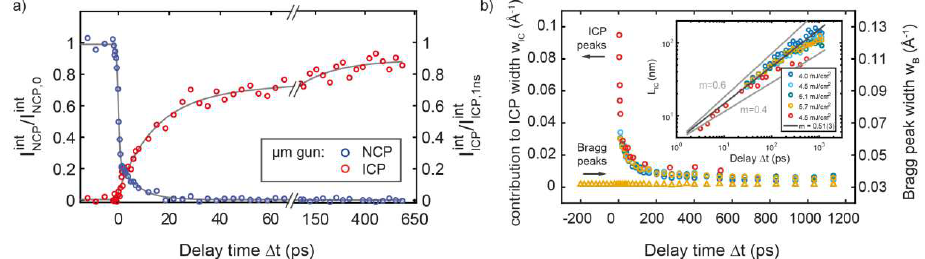
Fig. 2. a, Integrated CDW diffraction peak intensities recorded using the µm-sized gun. b, Time- dependent contribution to the width (FWHM) of the ICP diffraction peaks and width of lattice diffraction peaks for a range of optical-pump fluences. Red circles: data recorded with µm-sized gun. Inset: A double-logarithmic plot of the correlation length corrected for the instrument response function, indicating a power-law scaling for the phase-ordering kinetics (adapted from Ref.